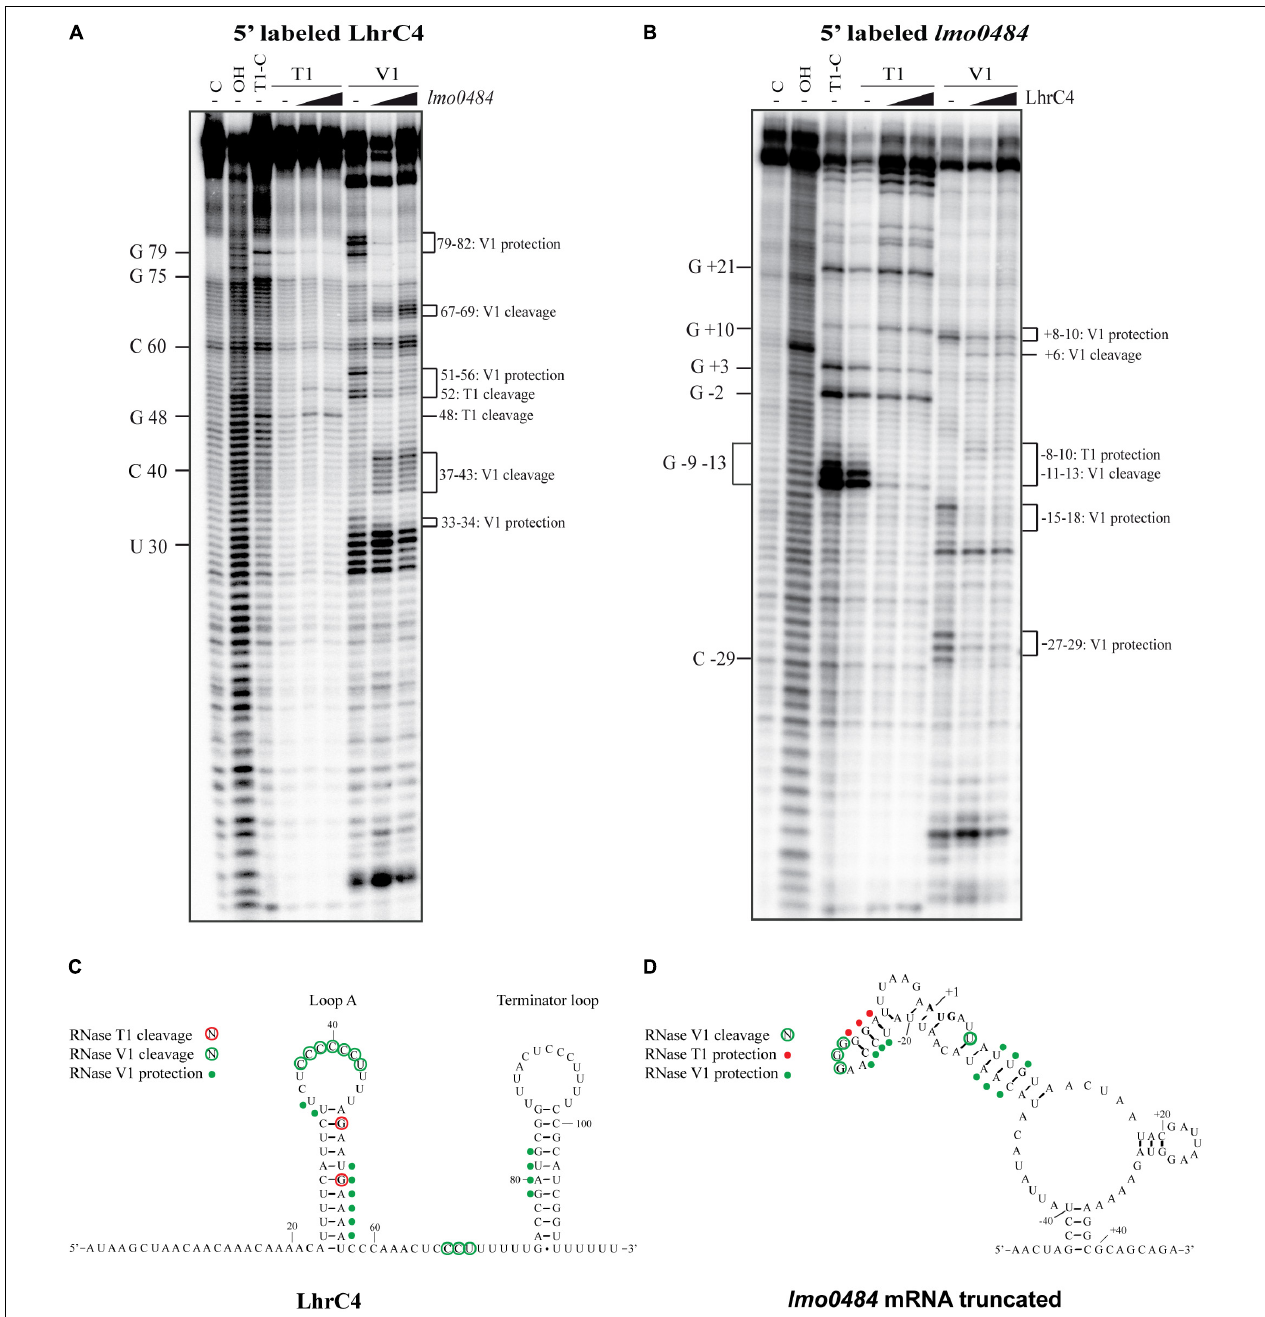
FIGURE 6 | Structure probing of LhrC4 and lmo0484 mRNA interaction. (A) 5 (cid:48) -end labeled LhrC4 was treated with RNase T1 or RNase V1, either in the absence (–) or in the presence of 25- or 250-fold excess of unlabeled lmo0484 RNA. As a control, untreated LhrC4 was separated in the first lane (C), an alkaline ladder (OH) is shown in the second lane and an RNase T1 ladder (T1-C) was separated in the third lane. For an overview, selected nucleotides are labeled on the left side. Nucleotides showing structural changes upon lmo0484 binding are marked on the right side of the gel. (B) Partial digestion of 5 (cid:48) -end labeled lmo0484 RNA with RNases T1 and V1. Untreated lmo0484 RNA (C), an alkaline ladder (OH) and an RNase T1 ladder (T1-C) are shown in the first three lanes. Some of the cleaved G residues are labeled along the left side of the gel. The lmo0484 nucleotides, that were protected or cleaved in the presence of LhrC4, are indicated on the right side of the gel. (C) Secondary structure of LhrC4 illustrating the cleavage pattern upon binding to lmo0484 mRNA. Residues cleaved by RNase T1 (red) or RNase V1 (green) are encircled. Residues of LhrC4, that appeared to be protected by lmo0484 RNA, are indicated by green dots. The nucleotides of LhrC4 are numbered relative to the 5 (cid:48) -end of the sRNA. (D) Secondary structure of the truncated version of lmo0484 mRNA showing an altered cleavage pattern upon the addition of LhrC4. Residues cleaved by RNase V1 (green) are encircled. Residues of lmo0484 RNA that were protected in the presence of LhrC4 are indicated by red dots (T1 protection) or green dots (V1 protection). The start codon is indicated in bold. The nucleotides of lmo0484 are numbered relative to the translation start site (+1).